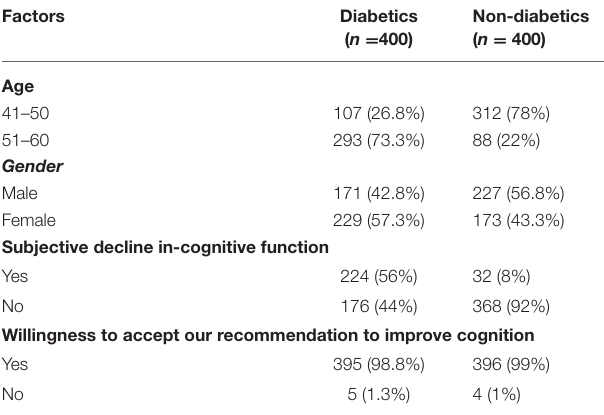
TABLE 1 | Characteristics of study